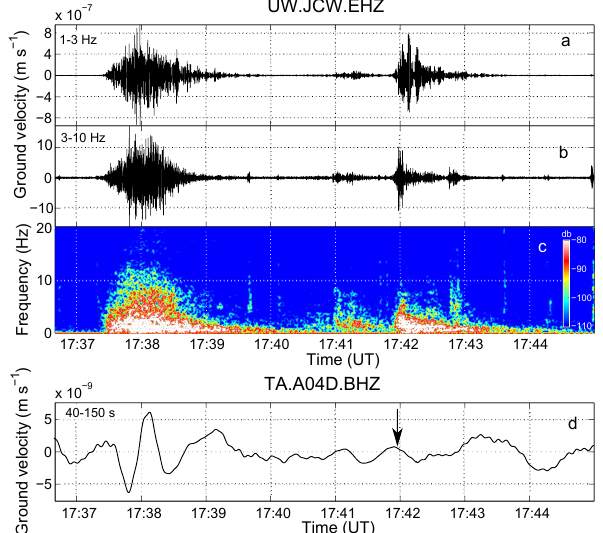
located 11.7km from the Oso-Steelhead landslide, filtered between (a) 1–3Hz and (b) 3–10Hz. (c) Spectrogram of the seismic signal computed using fast-Fourier transform, with an 8s moving window and a 90% overlap. (d) Long-period seismograms recorded at the station B05D and filtered between 40 and 150s (0.0067–0.025Hz). The black arrow indicates the onset time of the short-period seismic signal generated by the second